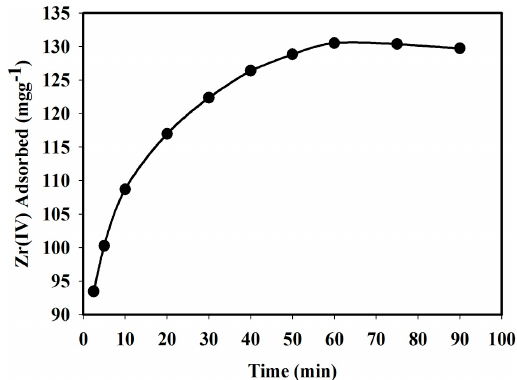
Figure 6. Effect of contact time on 150 mg·L − 1 Zr(IV) adsorption by 20 mg SG-APTMS-N,N-EPANTf 2 at pH 4.0 and 25 °C.